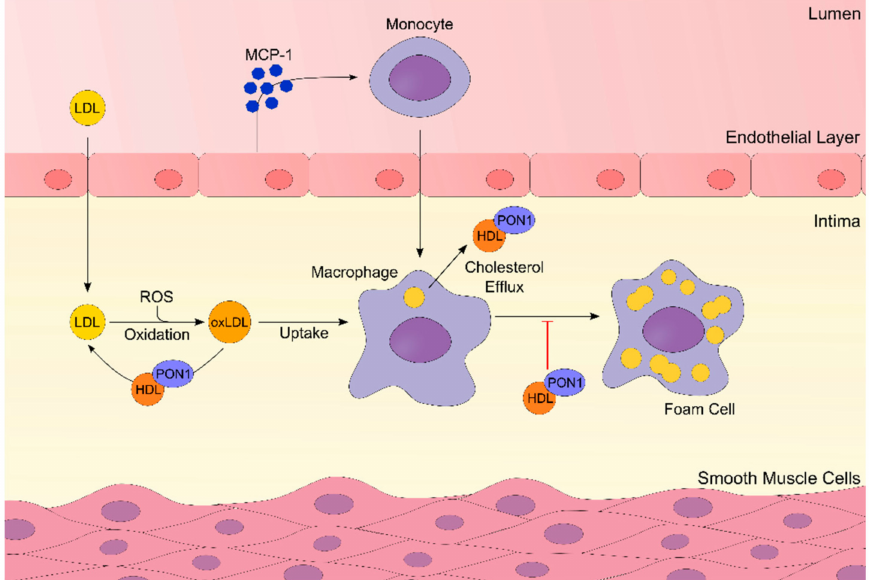
Figure 1. The role of Paraoxonase-1 (PON1) in the pathophysiology of atherosclerosis. Inflammation and oxidative stress lead to the oxidation of low-density lipoproteins (LDL). The release of monocyte chemoattractant protein-1 (MCP-1) from endothelial cells will lead to the recruitment of monocytes. These will di ff erentiate into macrophages, that will internalize the oxidized LDL (oxLDL), becoming foam cells. PON1 hydrolyzes the oxLDL, reverting it to LDL, and promotes cholesterol e ffl ux from macrophages, inhibiting the progression of atherosclerosis. (cid:97)